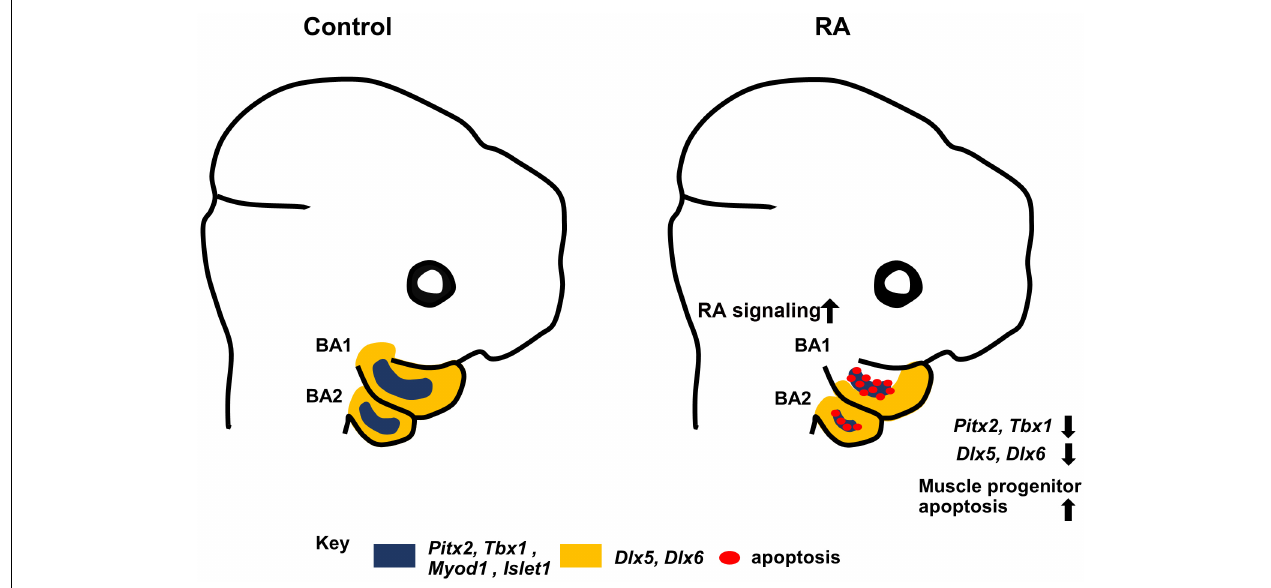
FIGURE 5 | Summary diagram. Excess RA signaling results in disrupted expression of Pitx2, Tbx1 , MyoD1, and Islet1 (blue) in myogenic progenitors, and Dlx5/6 (yellow) in CNCCs, together with elevated muscle progenitor apoptosis, which contributes to branchiomeric muscle defects in BA1 and